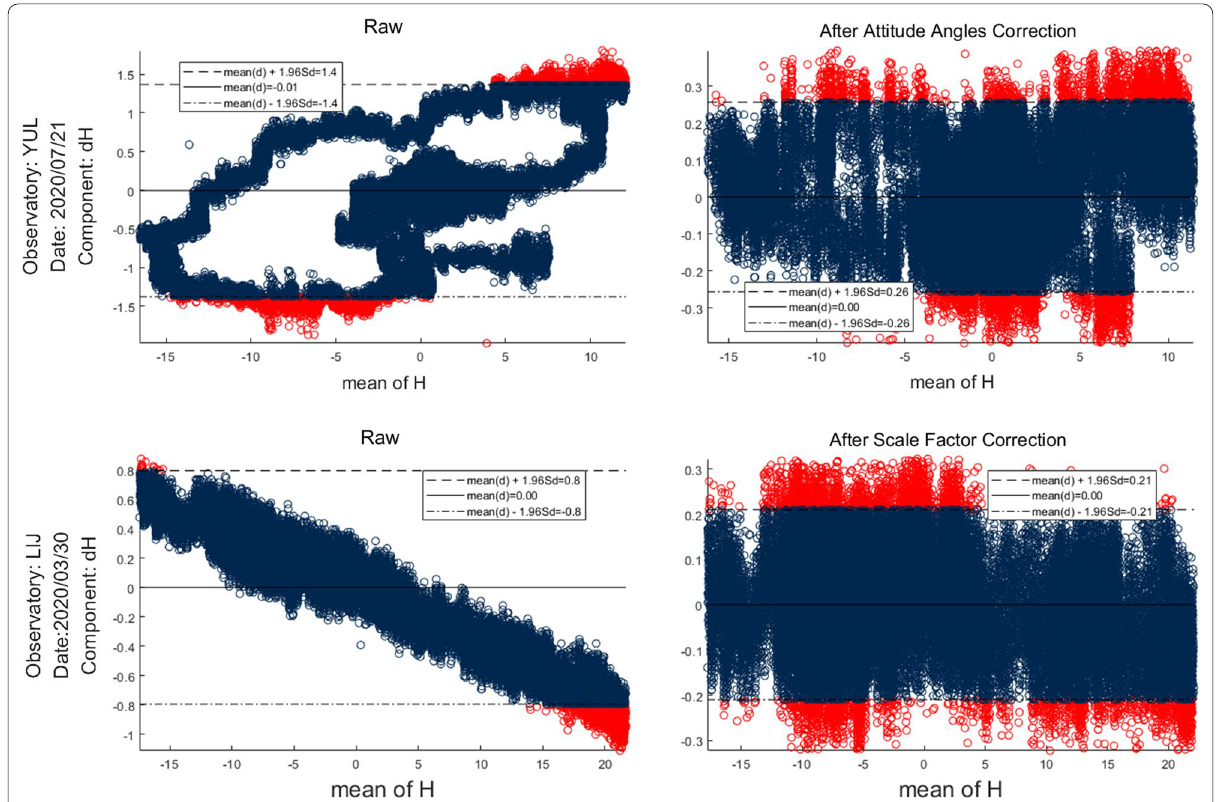
Fig. 11 Characteristics of the attitude angle and the scale factor in a B–A